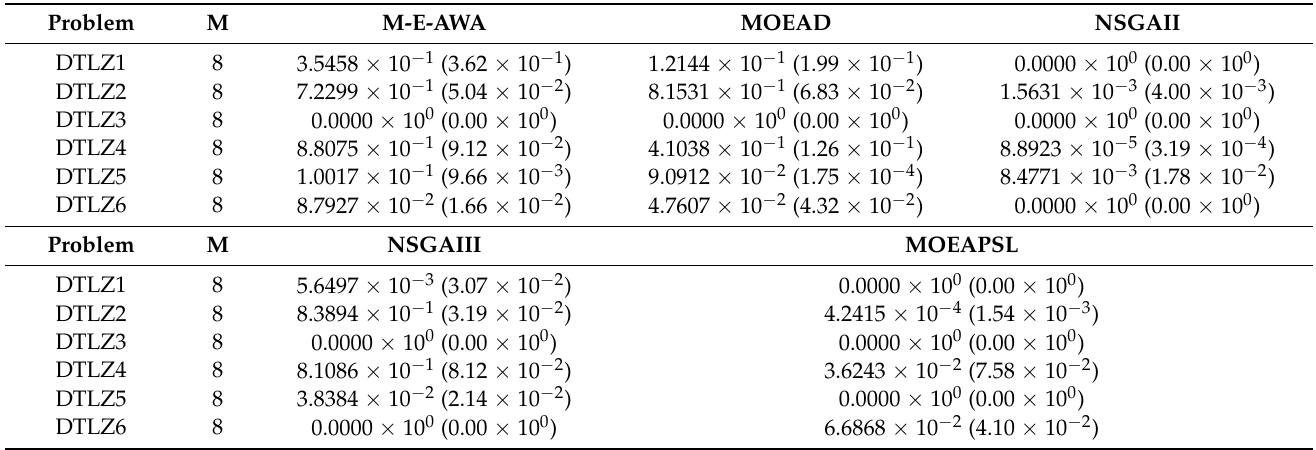
Table 6. Comparison of HV values between M-E-AWA and contrast algorithms on DTLZ1– DTLZ6(The target number is